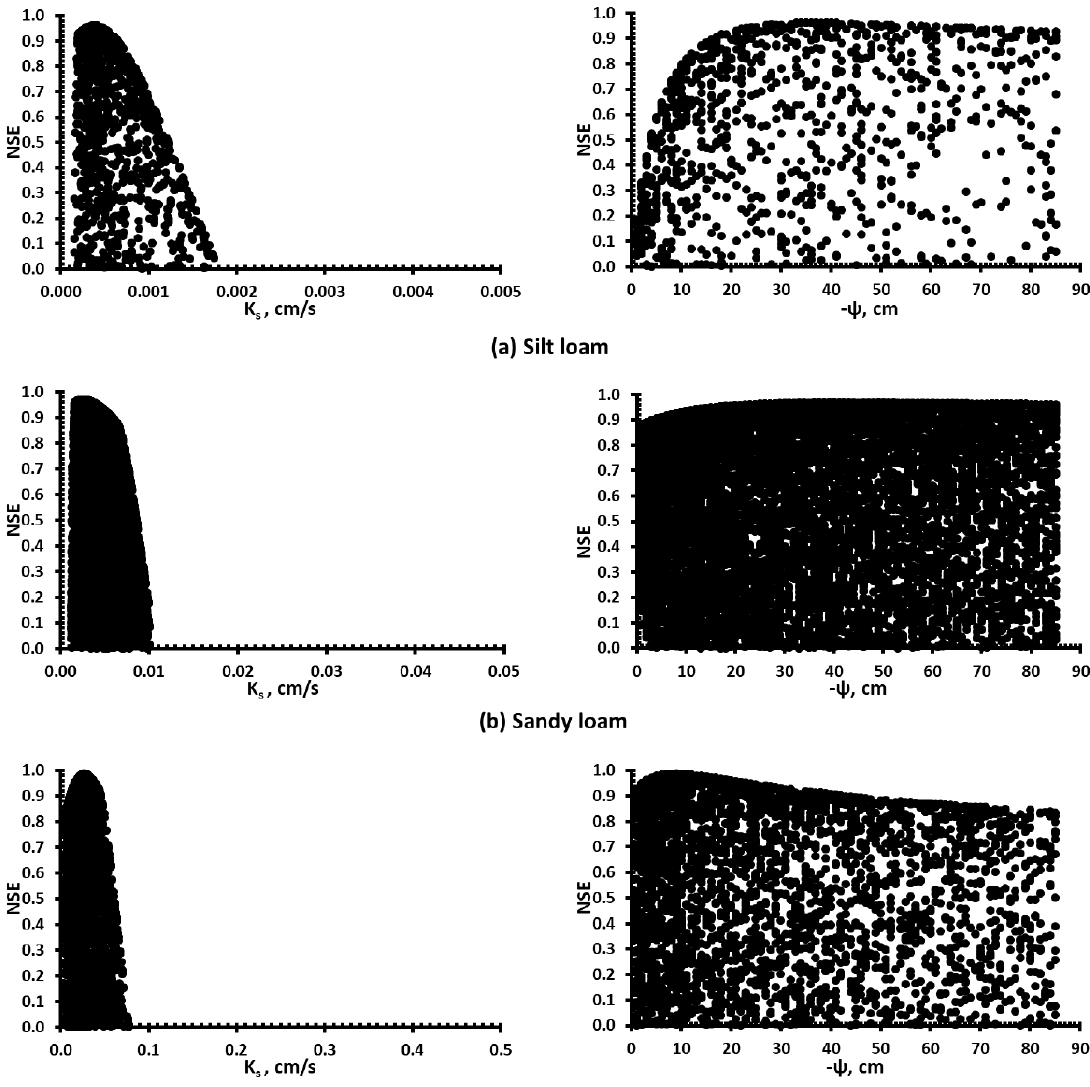
Figure 4. Scatter plots for the NSE calculated between ∆ t sj determined by Equation (6) and the measured time intervals ∆ t j , on the left is NSE versus K s (cm / s) and NSE versus - Ψ (cm) is on the right. ( a ) silt loam, ( b ) sandy loam, and ( c ) sand. The scales for K s are di ff erent for each of the three